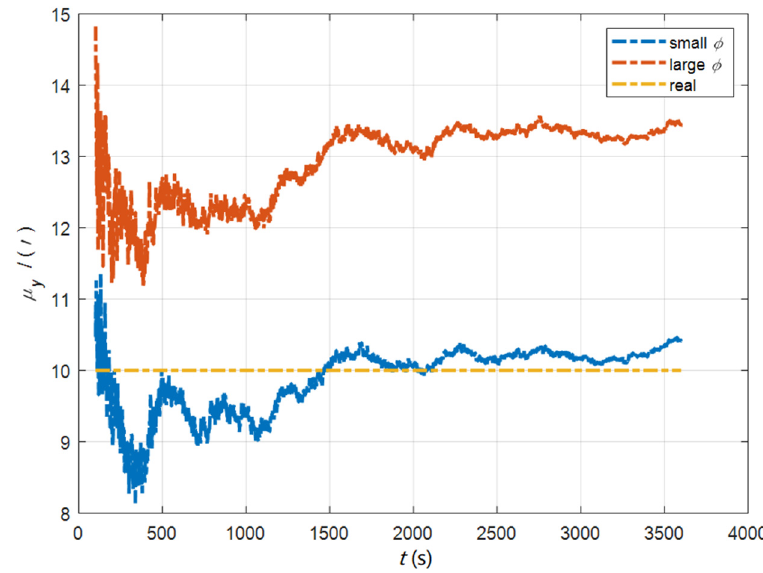
Figure 27. The curves of µ y in the case of large and small initial misalignment angles.